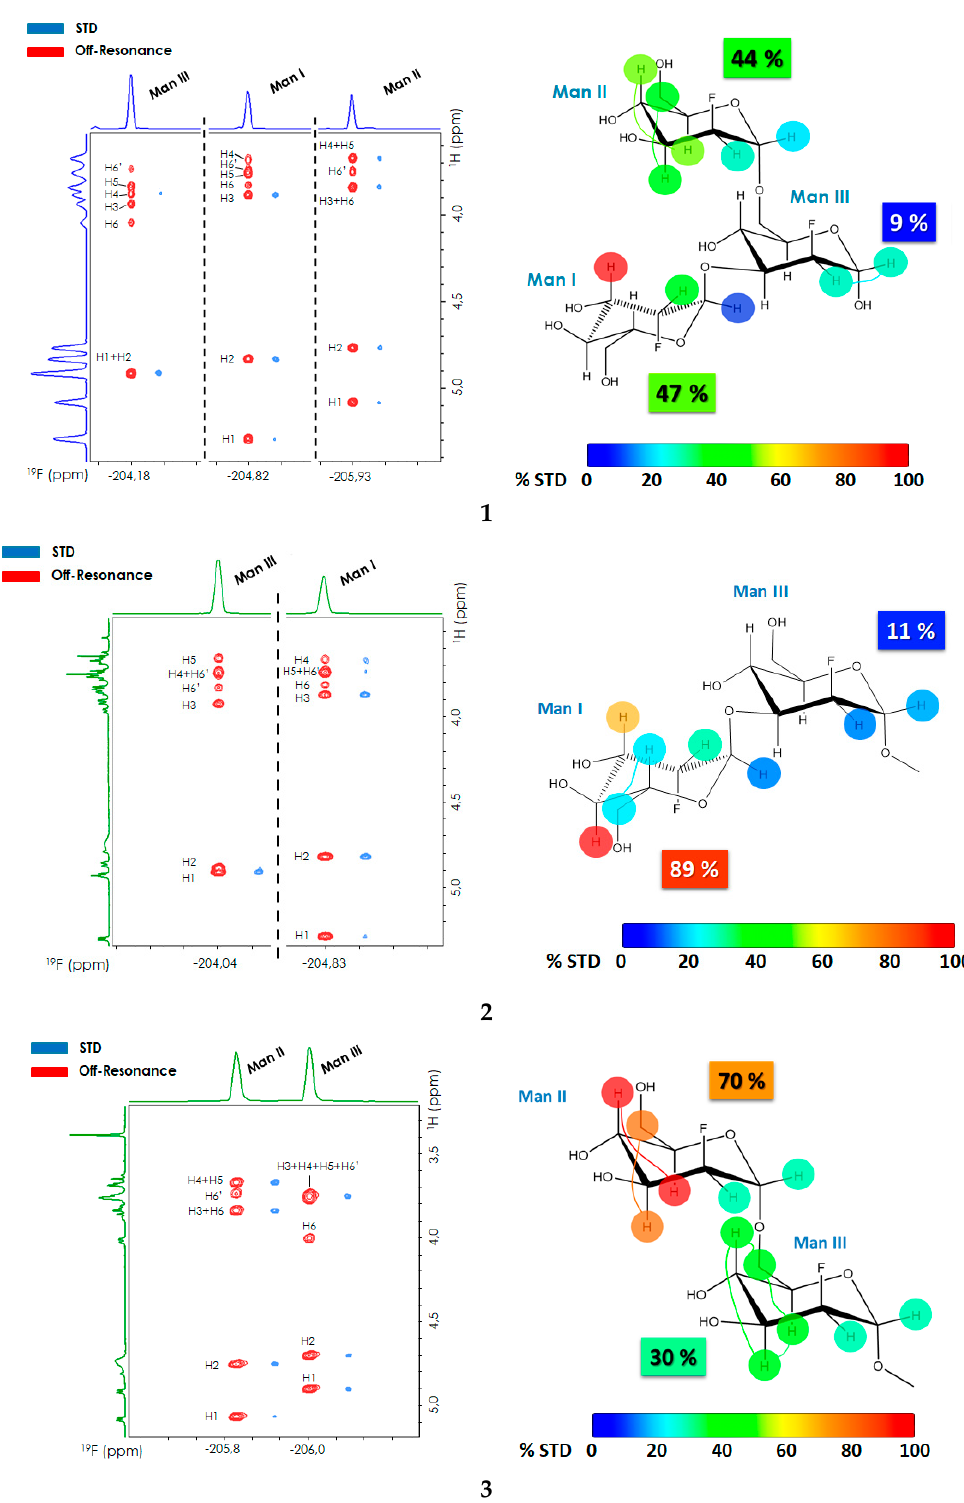
Figure 2. 2D-TOCSYreF off-resonance spectrum (red) and 2D-STD-TOCSYreF peaks (blue) obtained for 1 (top panel), 2 (central panel) and 3 (bottom panel) in the presence of DC-SIGN. The 19 F NMR frequencies are given in the abscissa axis and the 1 H NMR frequencies in the ordinate axis. The STD cross peaks are shifted to high field in the 19 F frequency to facilitate visual inspection. Every blue cross peak corresponds to the STD NMR intensity of the particular 1 H NMR nucleus in a given monosaccharide, which is encoded by the 19 F frequency. The ligand concentration was 1.4 mM in each